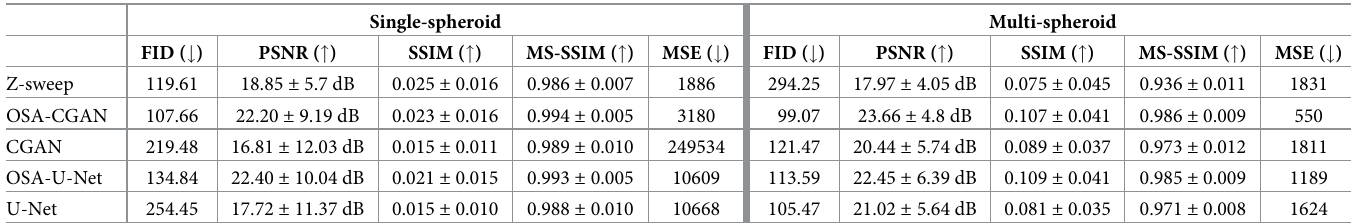
Table 1. Z-projection reconstruction performance on test set images as quantified by Frechet Inception Distance (FID), Peak Signal-to-Noise Ratio (PSNR), Struc- tural Similarity (SSIM), Mean Squared Error (MSE) and Multiscale SSIM (MS-SSIM). Performance is reported for the compared models as well as the input z-sweep to provide a baseline. Arrows indicate direction of improvement, meaning that an upward arrow indicates that a larger score is better and the opposite for a downward